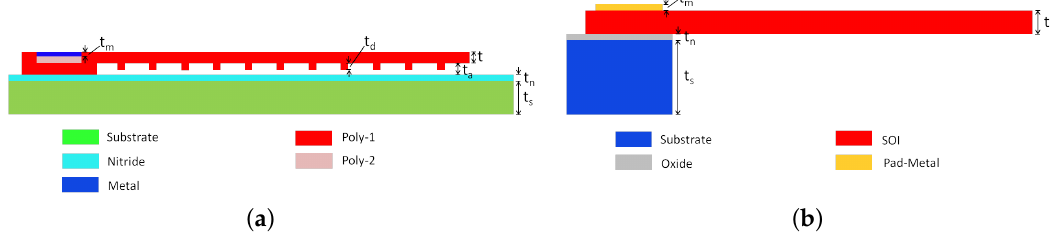
Figure 2. Cross-sectional schematic of the microgripper structure fabricated with the PolyMUMPs TM surface micromachining technology ( a ) and the SOIMUMPs TM bulk micromachining technology ( b ) (not-to-scale). Note that the PolyMUMPs TM process results in a suspended structure (i.e., with a small air gap between the device and the substrate) while the SOIMUMPs TM process results in an overhanging structure (i.e., the structure is totally exposed to ambient with no small air gap present).